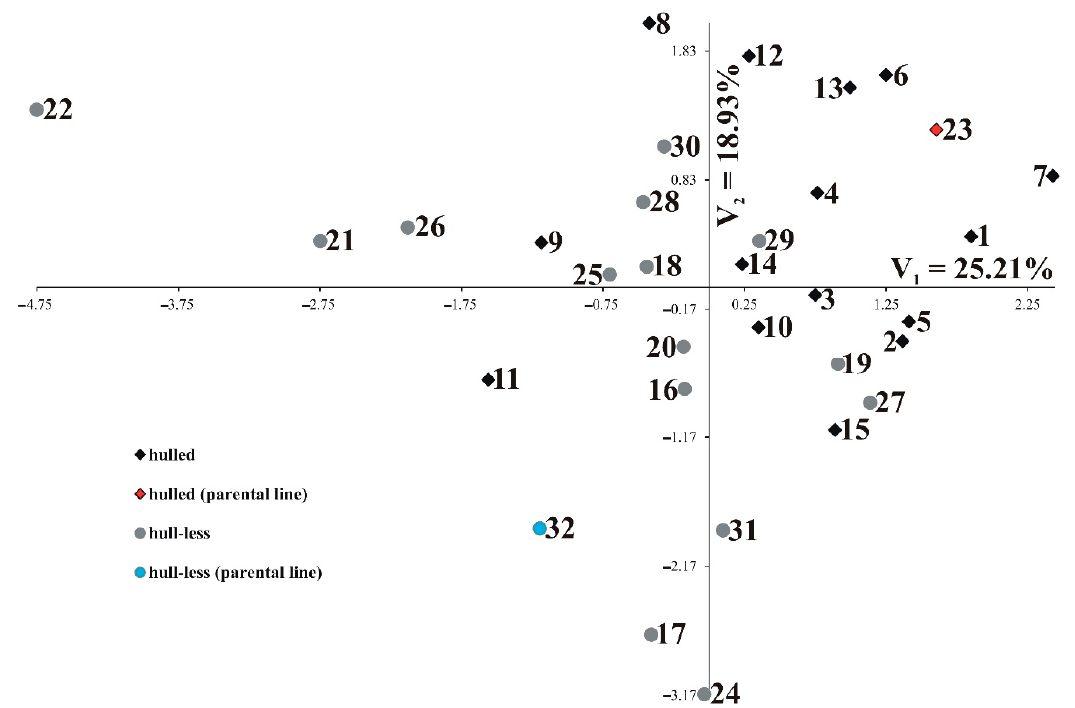
Figure 3. Distribution of 32 barley DH lines in space of two first canonical variables calculated on the basis of chlorophyll a fluorescence parameters (PI, Fv/Fm, Area, ABS/CS, TRo/CS, and ETo/CS) and yield components (biomass, grain number per plant (GNP), and thousand-grain weight (TGW)). Table 4. Correlation coefficients between the first two canonical variables and original traits of bar- ley DH lines. Trait